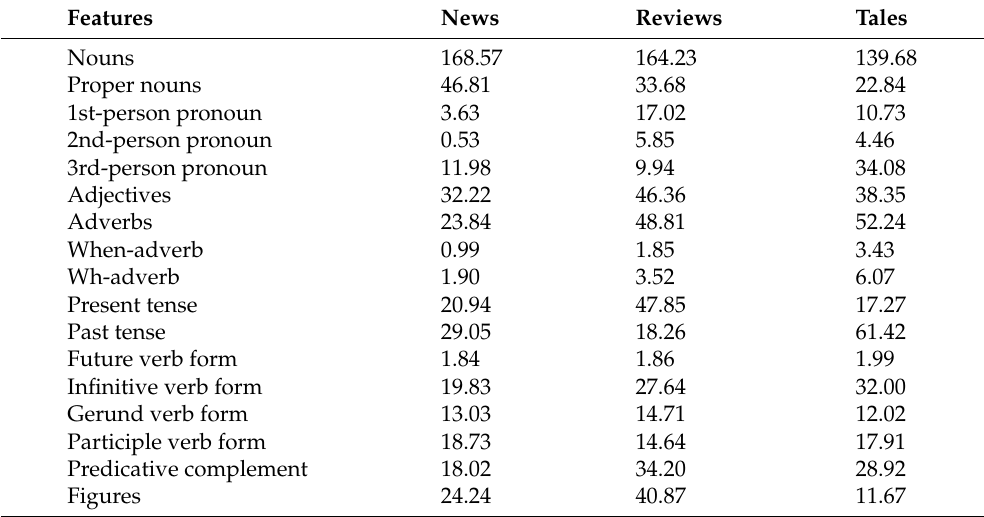
Table 3. Average POS and syntactic features per